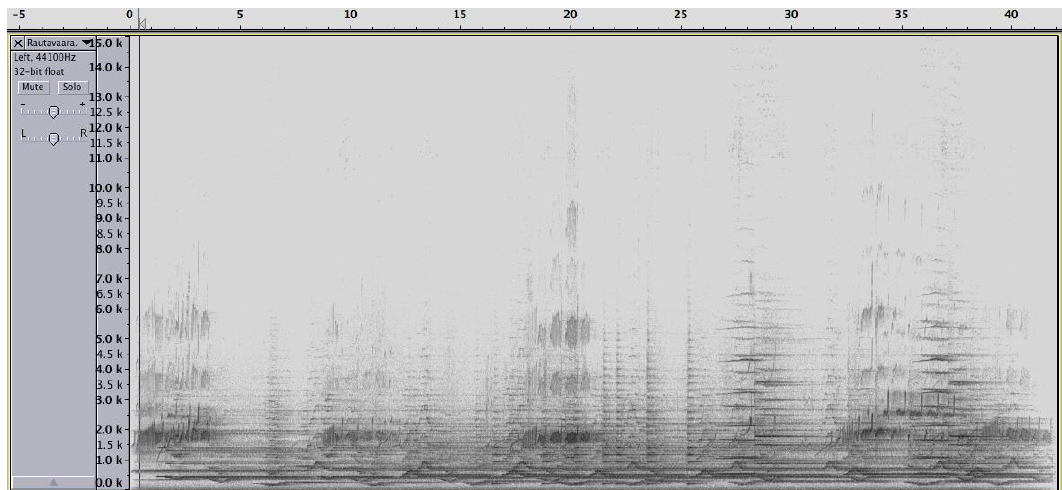
Figure 1. Spectrogram of the beginning (starting at measure 24) of Rautavaara’s Cantus Arcticus. The sounds of the symphonic orchestra are intermingled with bird calls, with typical recognizable and repeated visual patterns.